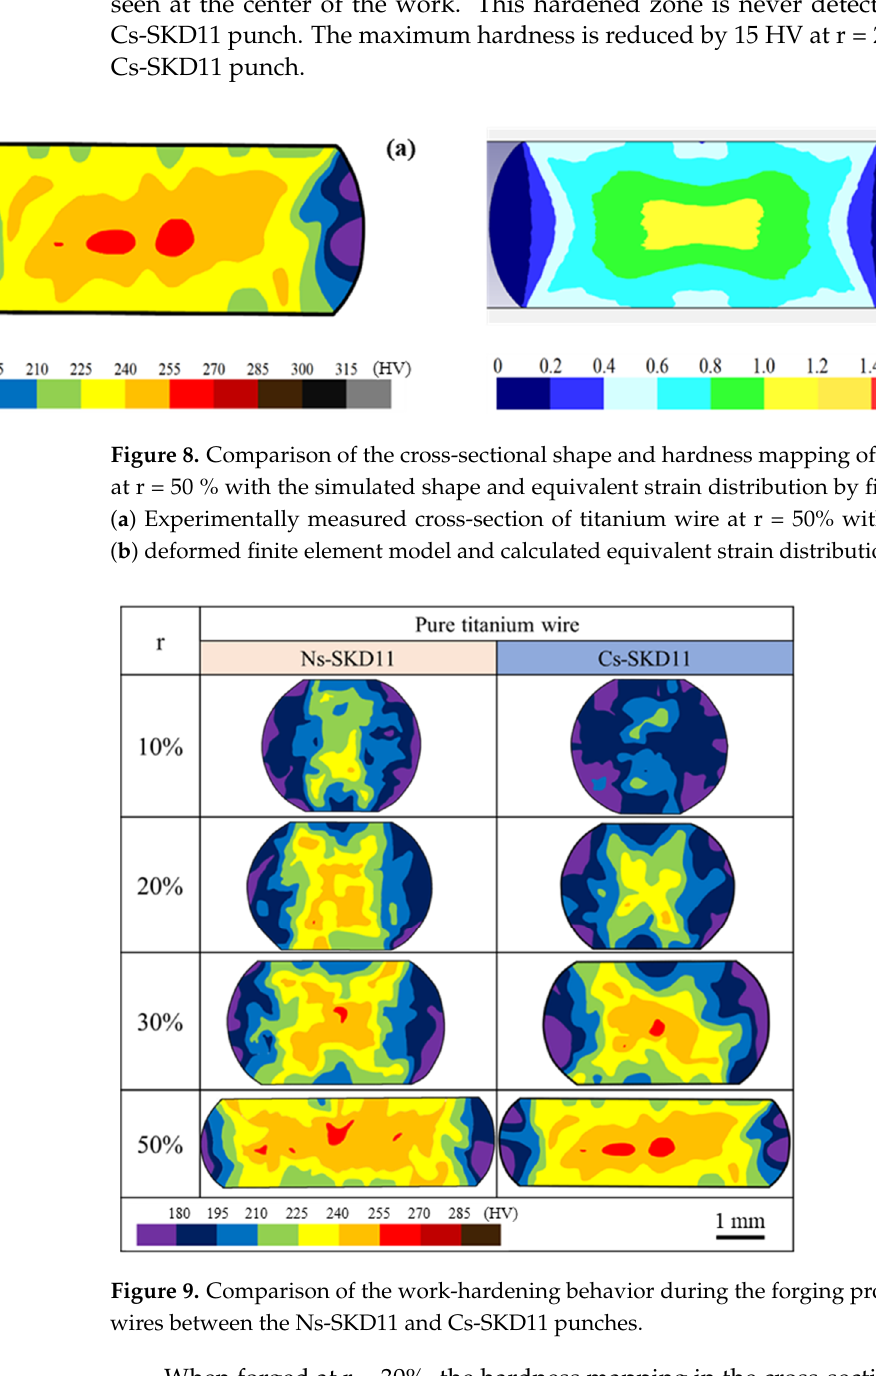
Figure 8. Comparison of the cross-sectional shape and hardness mapping of forged pure titanium at r = 50 % with the simulated shape and equivalent strain distribution by finite element analysis. ( a ) Experimentally measured cross-section of titanium wire at r = 50% with hardness map, and ( b ) deformed finite element model and calculated equivalent strain distribution by FEA.